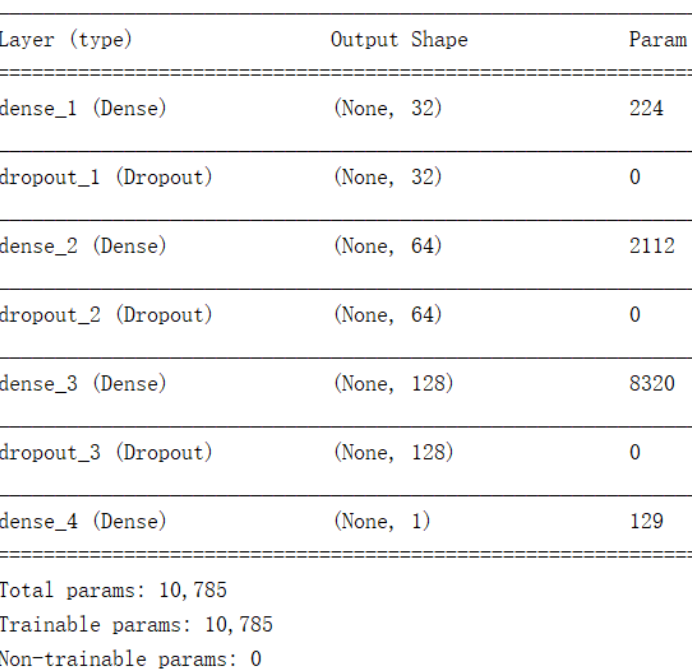
Figure 10. BP neural network training